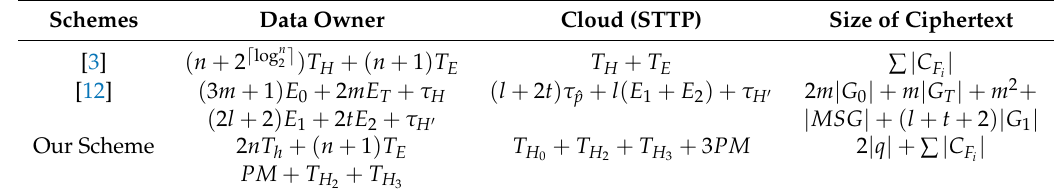
Table 4. Comparison of Computational Complexity and Size of Ciphertext in the Data Store Phase.